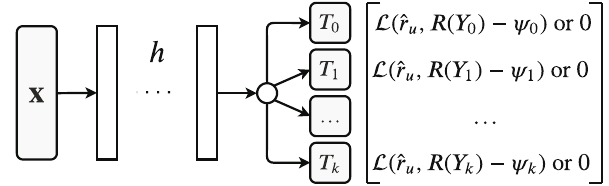
Figure 4: A general ANN architecture for CATE estimation. Having x as the input; h the hidden layers; L a loss function; T i is short for T i = ; and Y i is short for Y after T i = . Note that in a biased sample setting, we use the fl exibility of ANNs to incorporate any balancing terms to counter covariate shift, such as those presented in ref. [ 10 ]